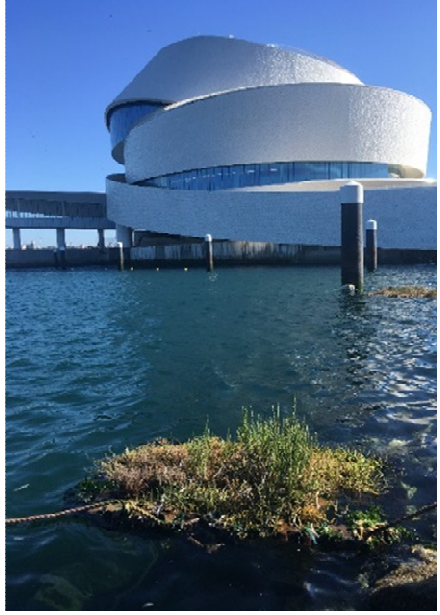
Figure 3. Floating wetland island in the marina of the Porto Cruise Terminal.